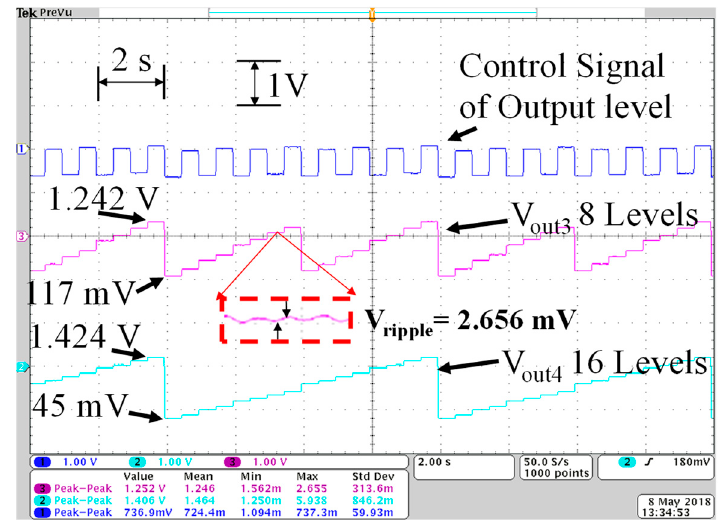
Figure 18. The measured results of the output voltage levels and the ripple voltage of the proposed SSC-DVS.